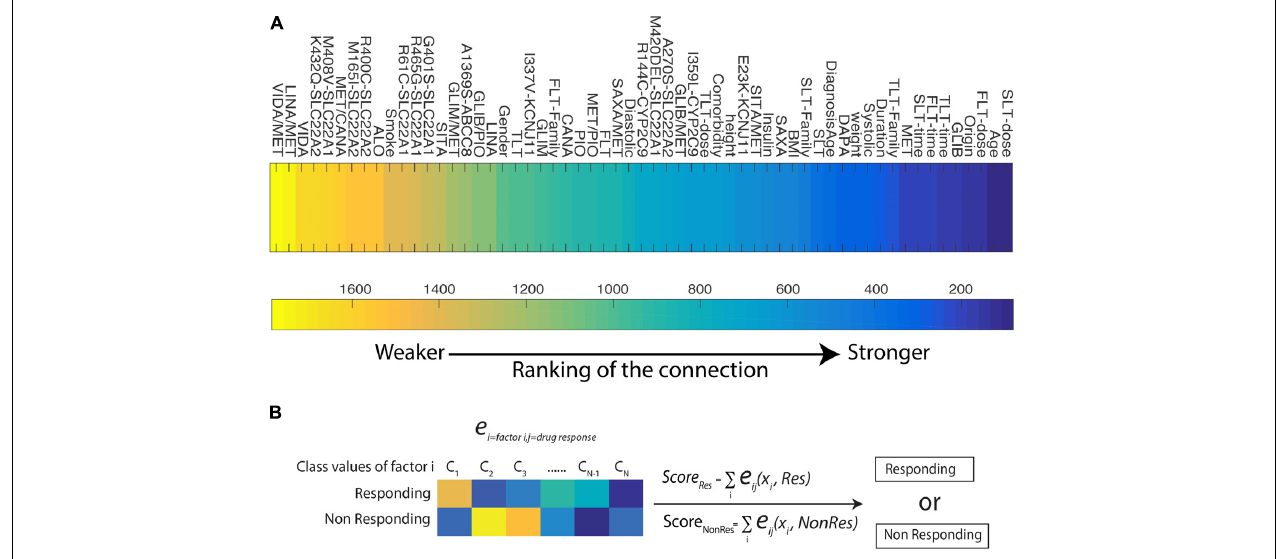
FIGURE 3 | (A) Heat map for the ranking of each factors and HbA1c test result among all the pairwise pool. The lower value of the ranking indicates stronger connectivity. (B) A predictive model for patient’s drug response to OAD